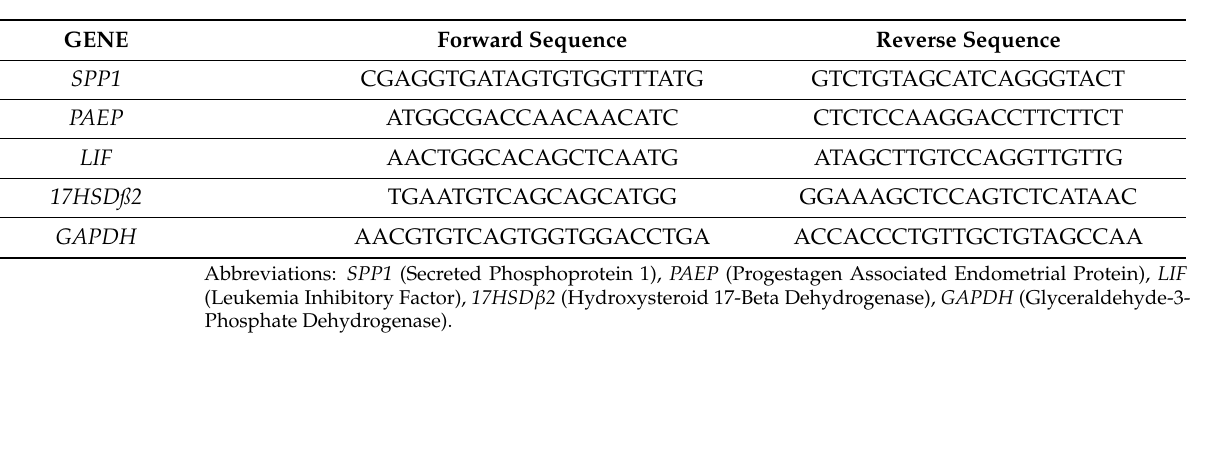
Table 3. Primers